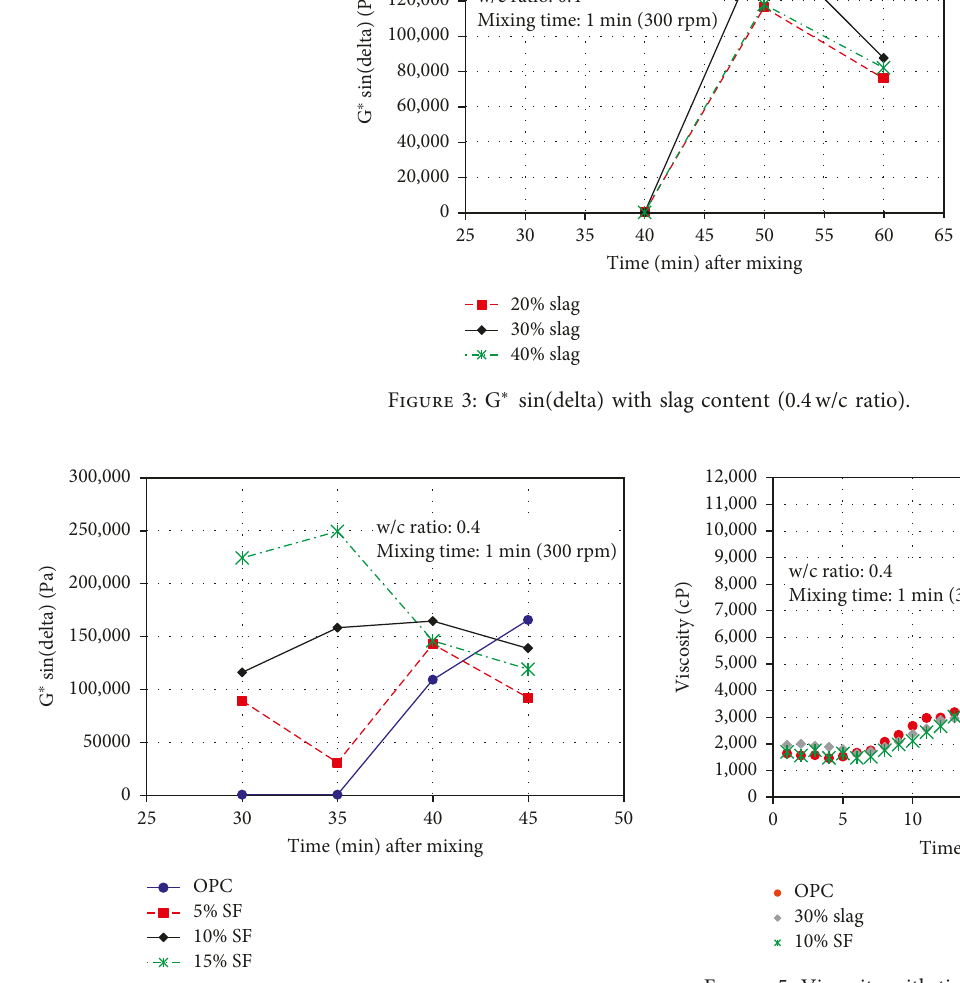
Figure 4: G sin(delta) with silica fume content (0.4w/c ratio). ∗